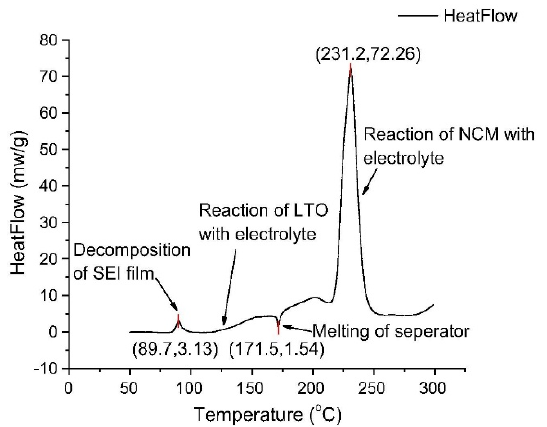
Figure 4. Heat flow vs. temperature for the entire battery [23].